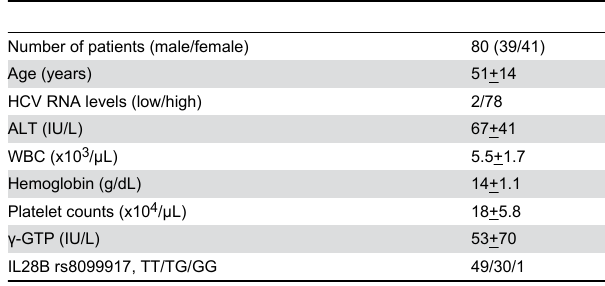
Table 1. Clinical characteristics of HCV genotype 1-infected in the present study.